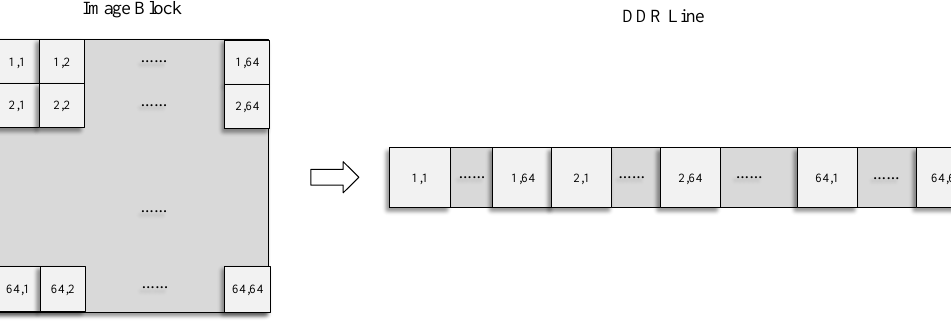
Figure 8. Single image block mapping method.